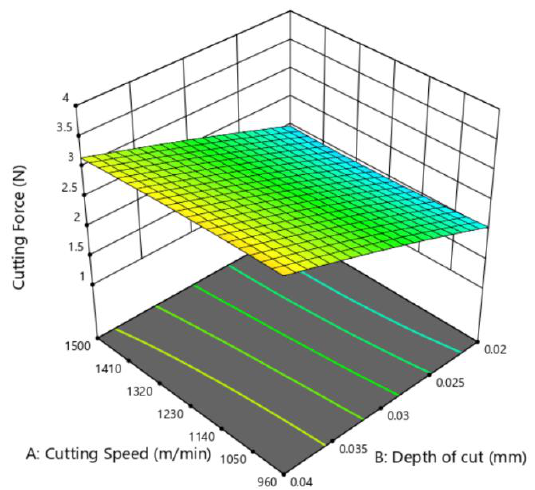
Figure 11. Response surface of the depth of cut and cutting speed on cutting force.